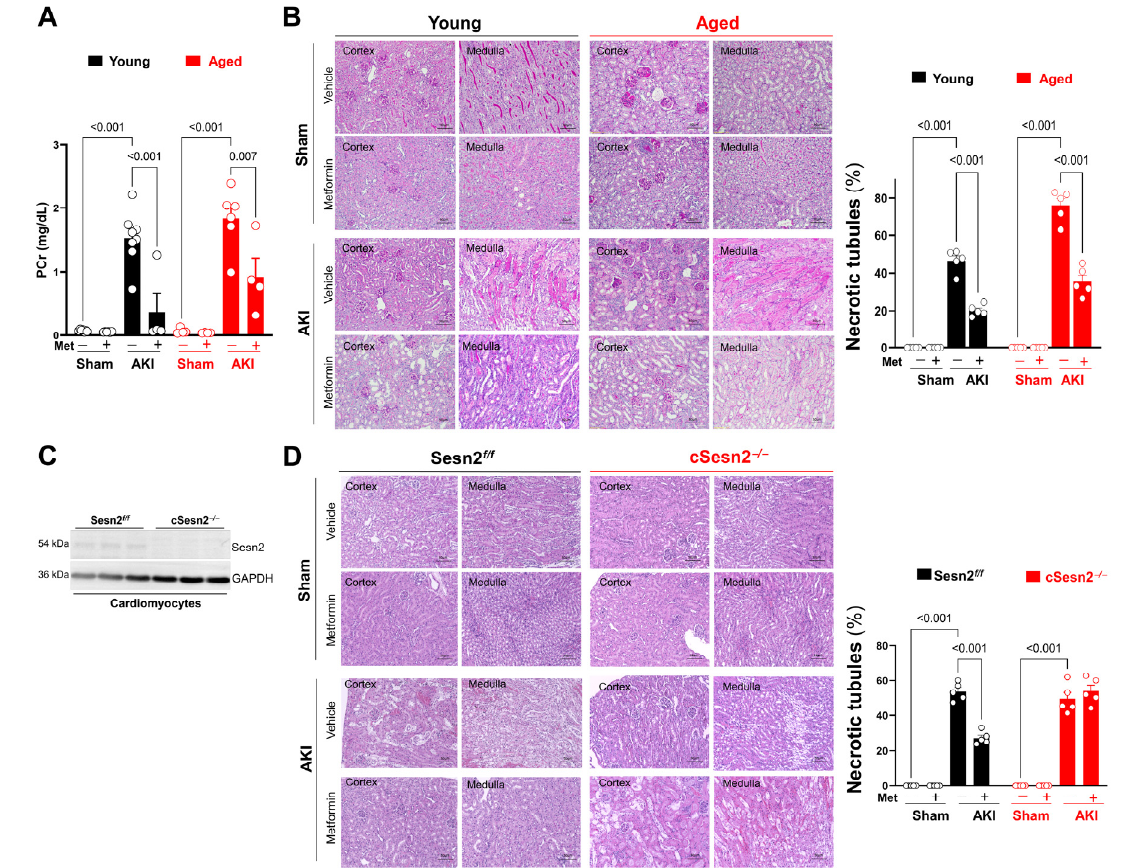
Figure 2. Effects of AKI surgery and metformin on renal structure and function. ( A ) Plasma creatinine concentration (PCr); means ± SEM; n = 4–8 per group. ( B , D ) Representative H&E staining and statistical analysis; means ± SEM; n = 5 per group. ( C ) Immunoblotting of Sesn2 with isolated cardiomyocytes from Sesn2 f/f or cSesn2 − / − mouse